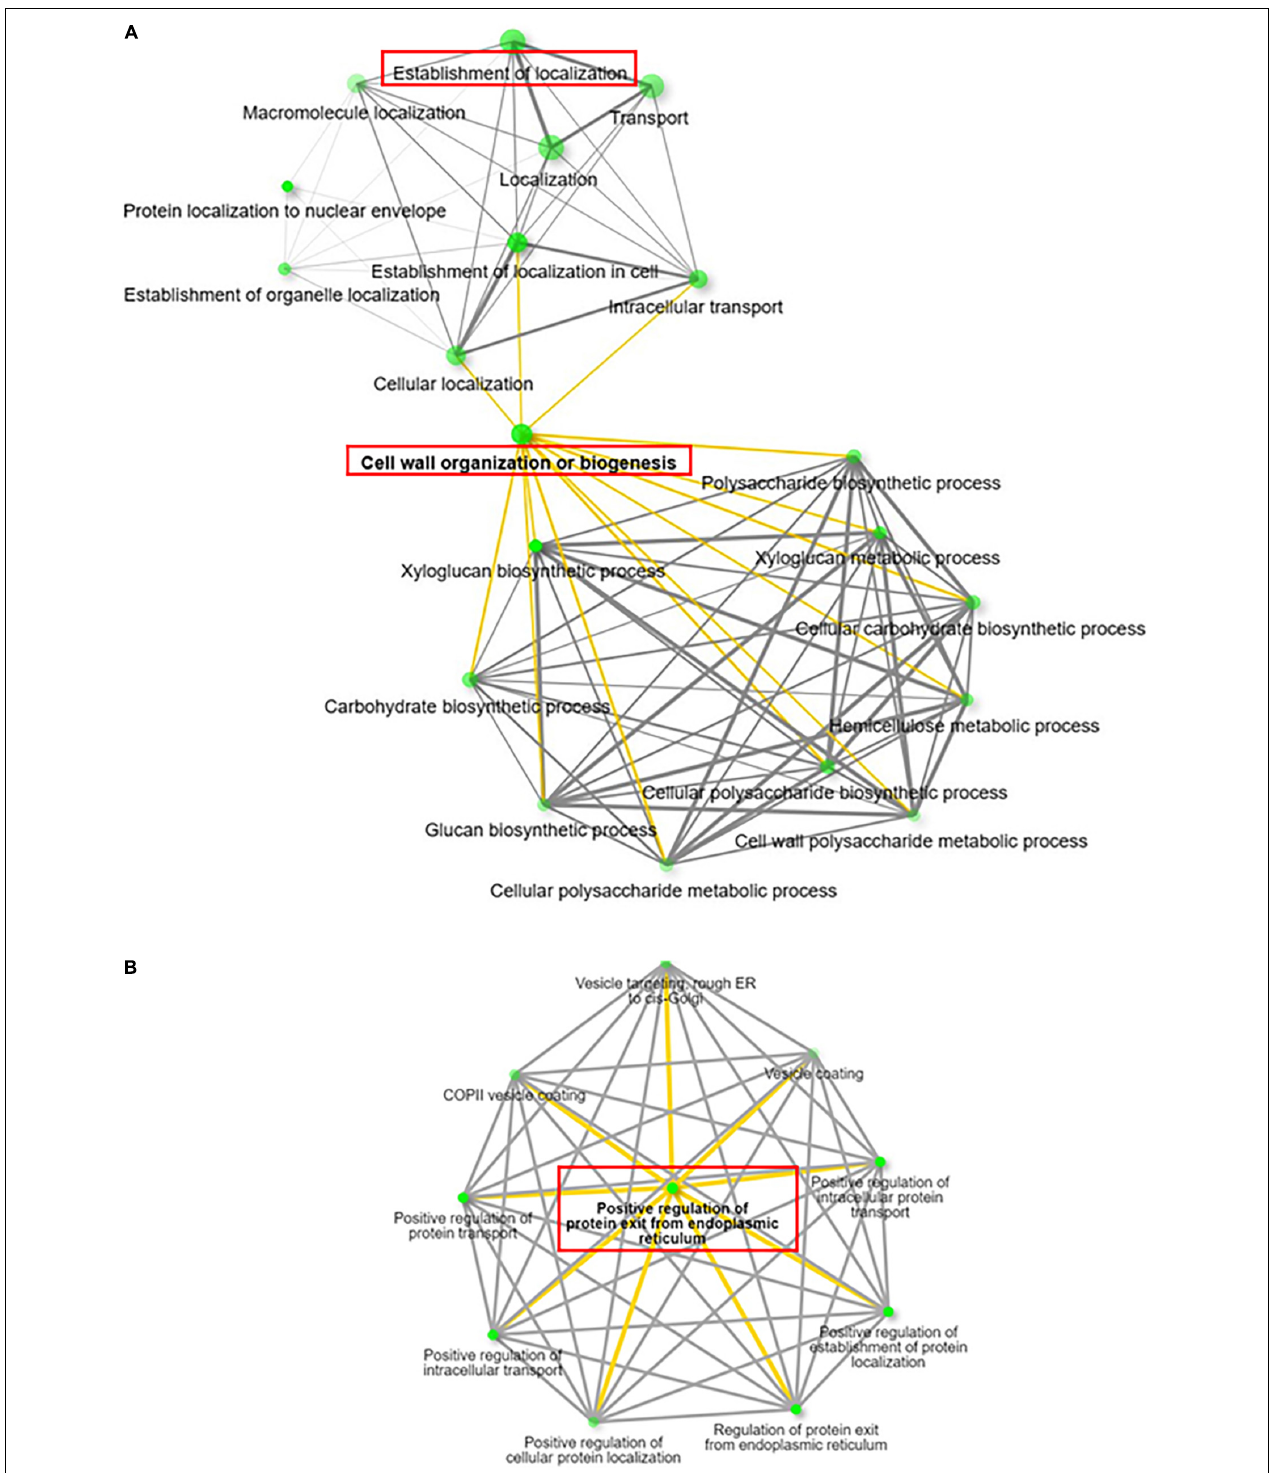
FIGURE 8 | Interconnection of enriched GO terms of up and downregulated genes. Visualization of GO term networks of up (A) and down (B) regulated genes identified through PM Proteomic analysis using ShinyGo (v0.61) (Ge et al., 2020). Note in (A) the enrichment of two major pathways in the RabA2b OE lines: Establishment of localization and Cell wall Biogenesis. In (B) , note that the downregulated genes are involved mainly in regulating the trafficking from ER to Golgi. The nodes (Green dots) represent the GO biological processes (BP) while the lines (yellow and gray) represent the interaction between the nodes having a minimum of 20% genes common between two connected